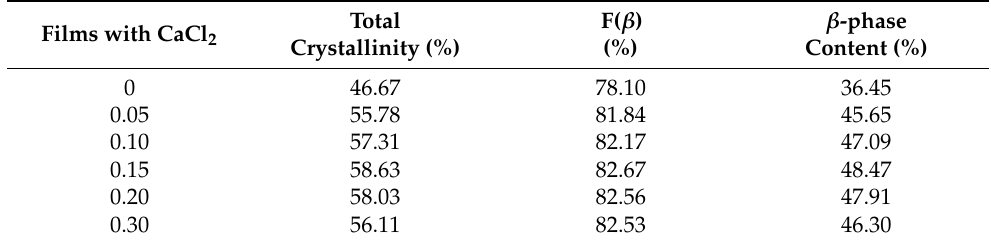
Table 1. Crystallinity, F( β ), and β phase content of PVDF/CaCl 2 composite film. Films with CaCl 2 Total */#Crystallinity ( % ) F ( β ) */# ( % ) β ‐ phase */#Content ( % )